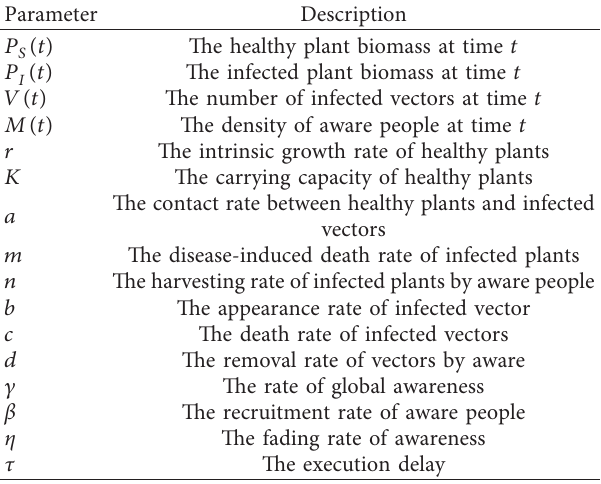
Table 1: Descriptions of parameters in